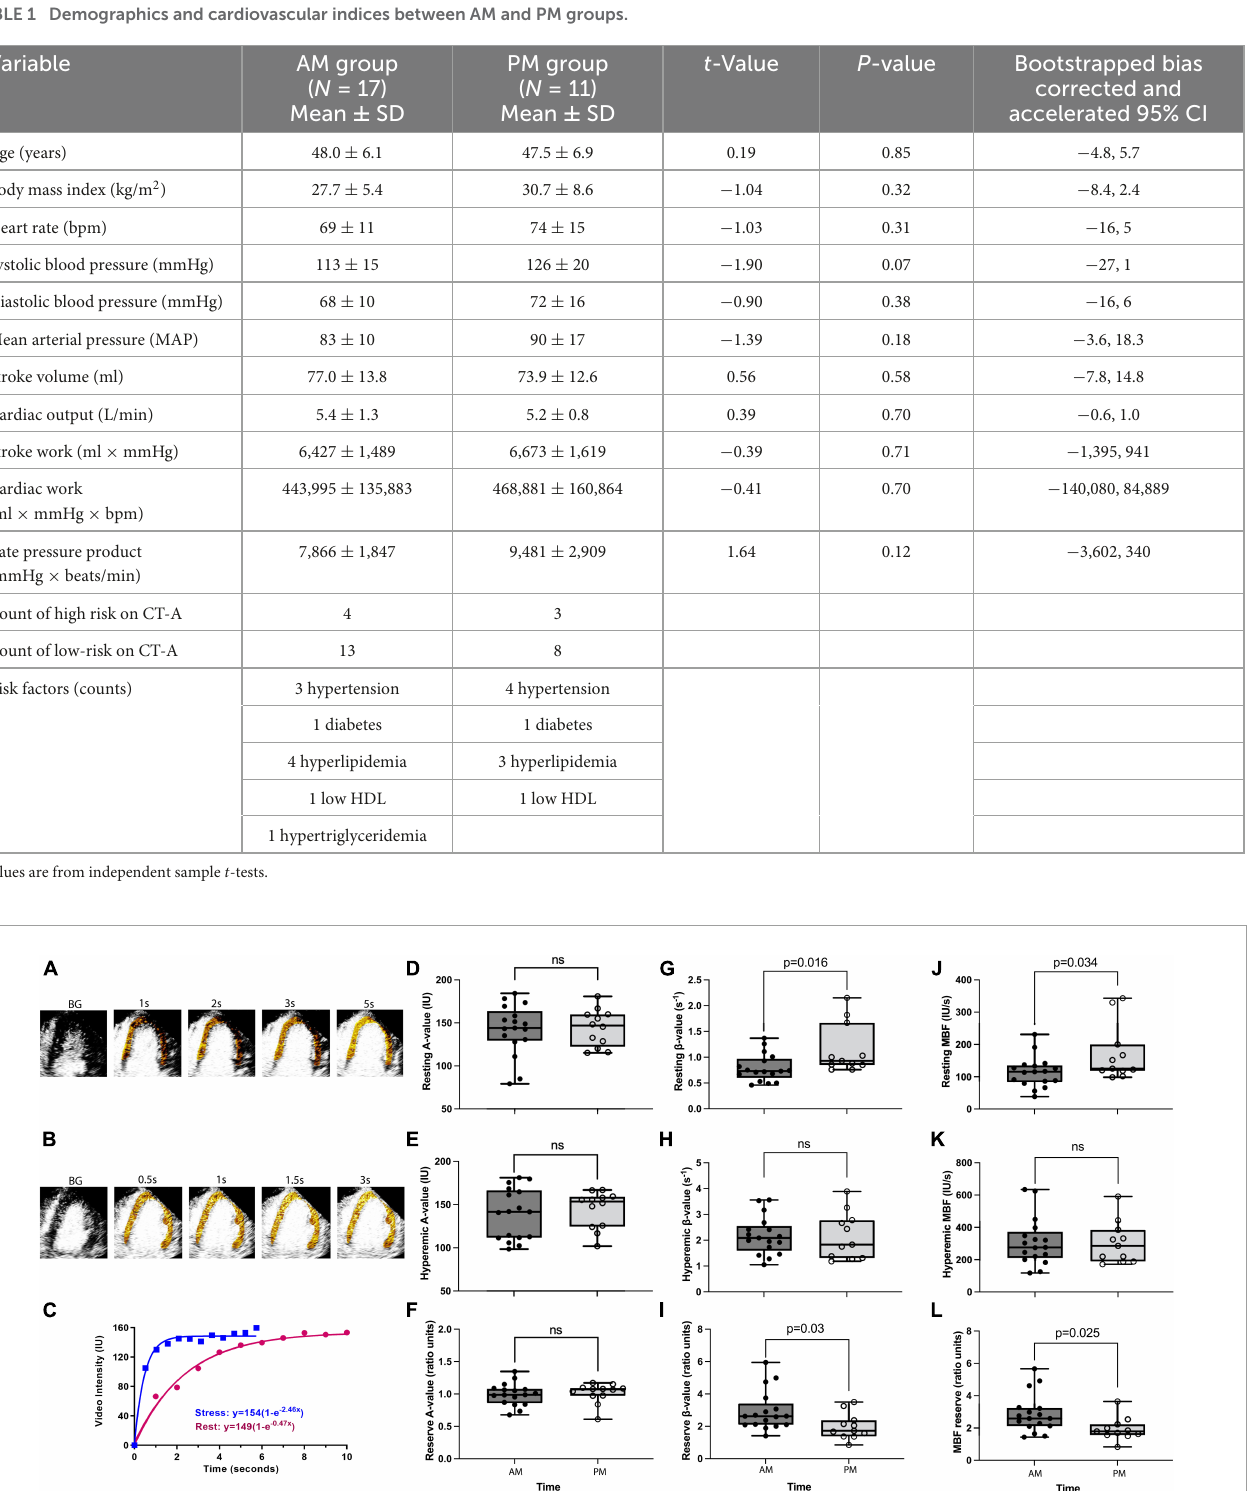
TABLE 1 Demographics and cardiovascular indices between AM and PM groups.